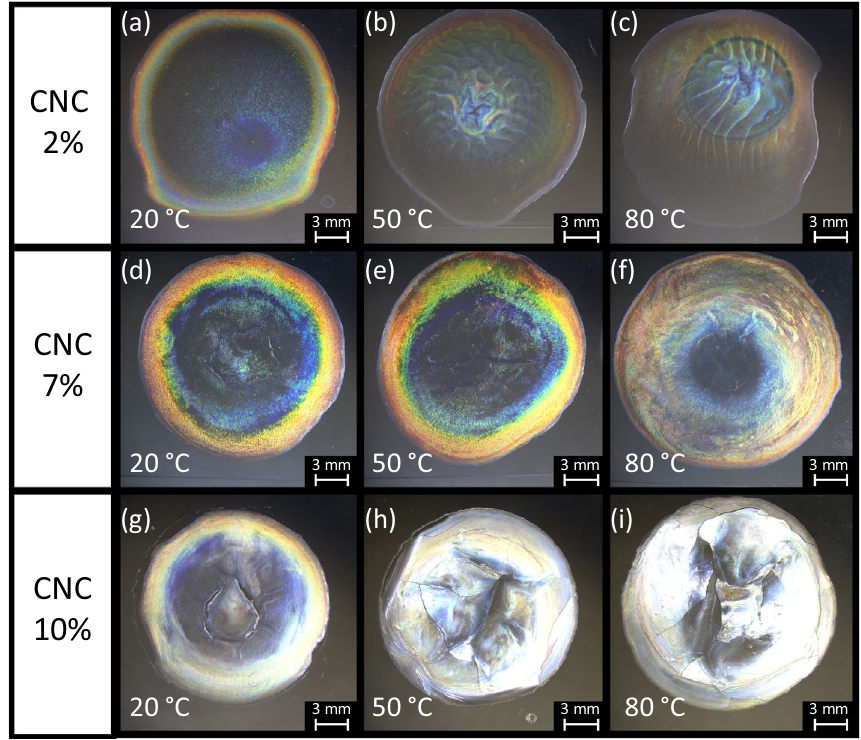
Figure 4. CNC droplets dried under various constant temperatures from suspensions of ( a ) ‒ ( c ) 2%, ( d ) ‒ ( f ) 7%, and ( g ) ‒ ( i ) 10% CNCs. These images were acquired in reflection mode under white light without